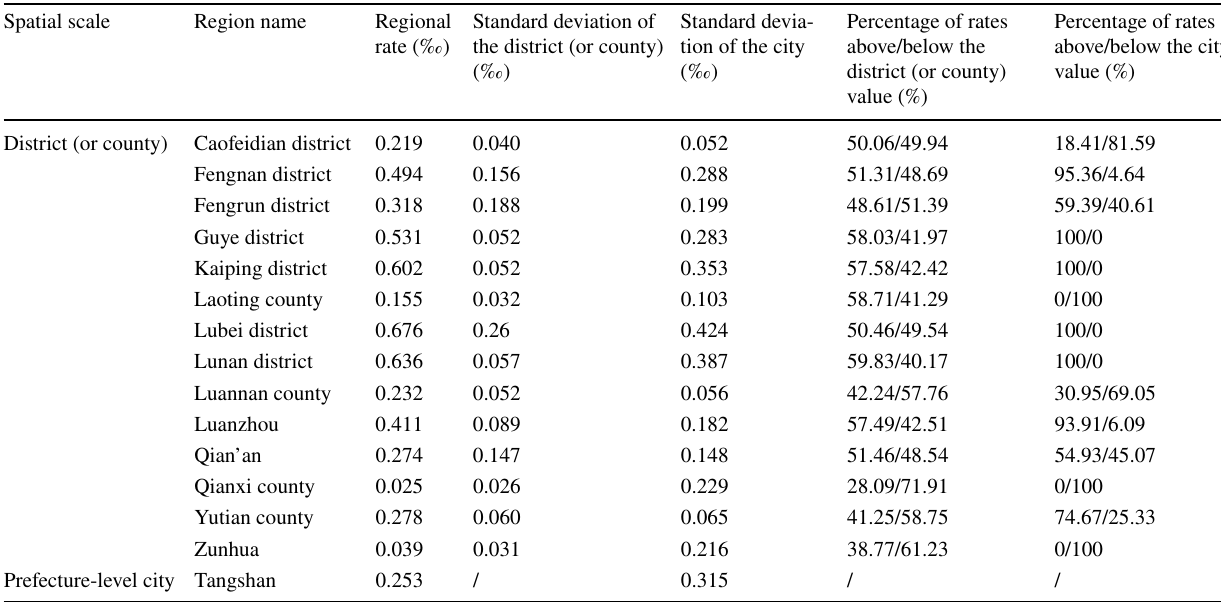
Percentage of rates above/below the city value (%)